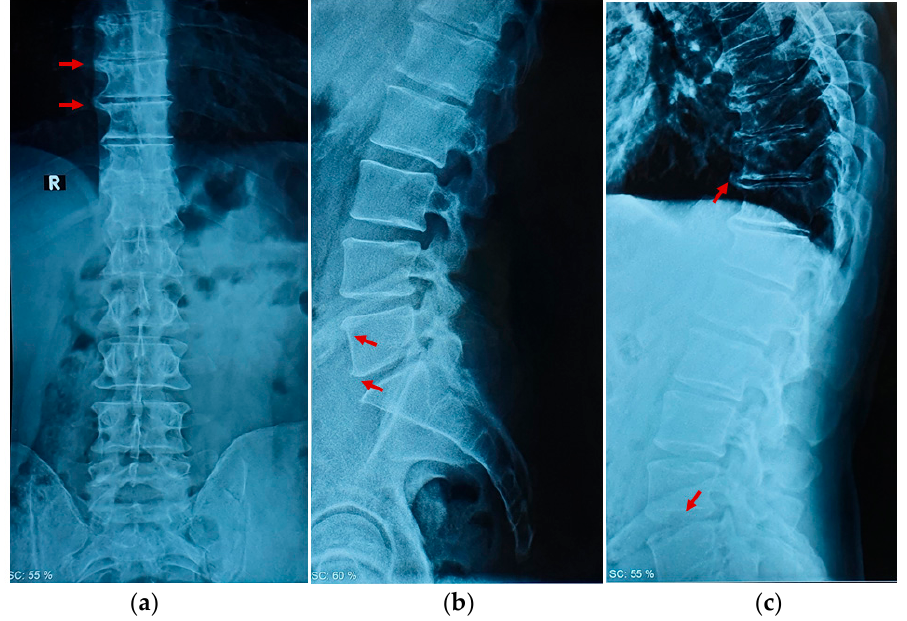
Figure 1. Radiographic examination of the spine: ( a ) represents the coronal plane, and the red arrows indicate the osteoarthritic degeneration at the right side of the vertebrae; ( b ) represents the sagittal plane of the lumbar region, and the red arrows indicate the presence of osteophytes at L5; ( c ) represents the sagittal plane of the thoracic and lumbar region, and the red arrows indicate the osteoarthritic degeneration of both segments.